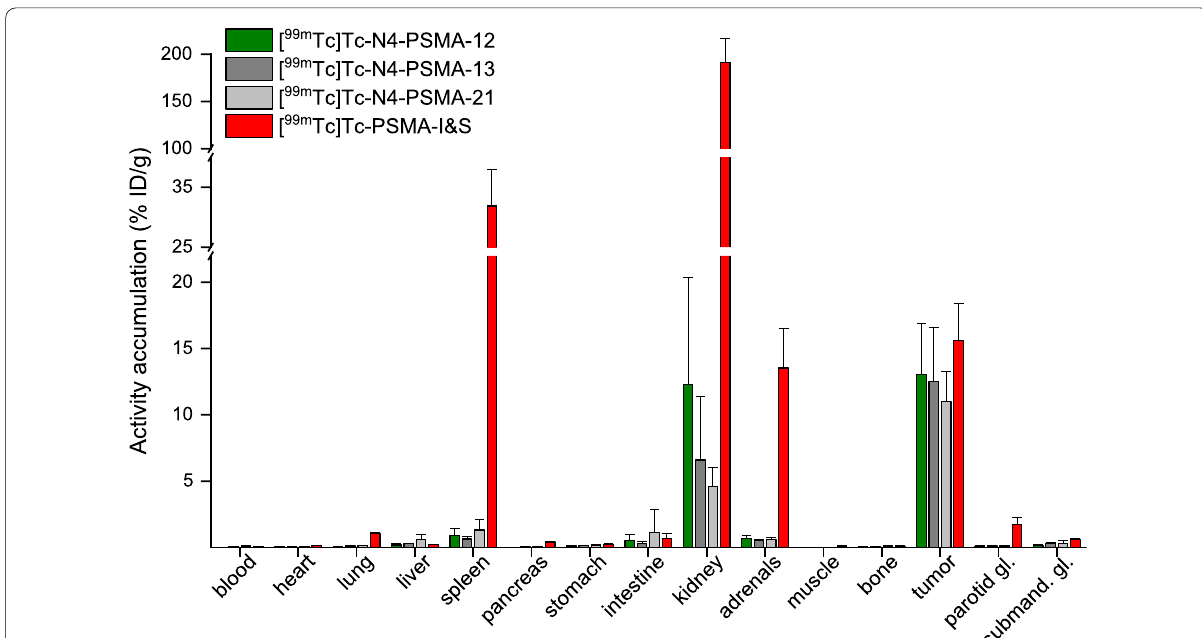
Fig. 3 Ex vivo biodistribution data of 99m Tc‑labeled N4‑PSMA derivatives and [ 99m Tc]Tc‑PSMA‑I&S at 6 h p.i. in male LNCaP tumor‑bearing CB17‑SCID mice. Data are expressed as a percentage of the injected dose per gram (% ID/g), mean